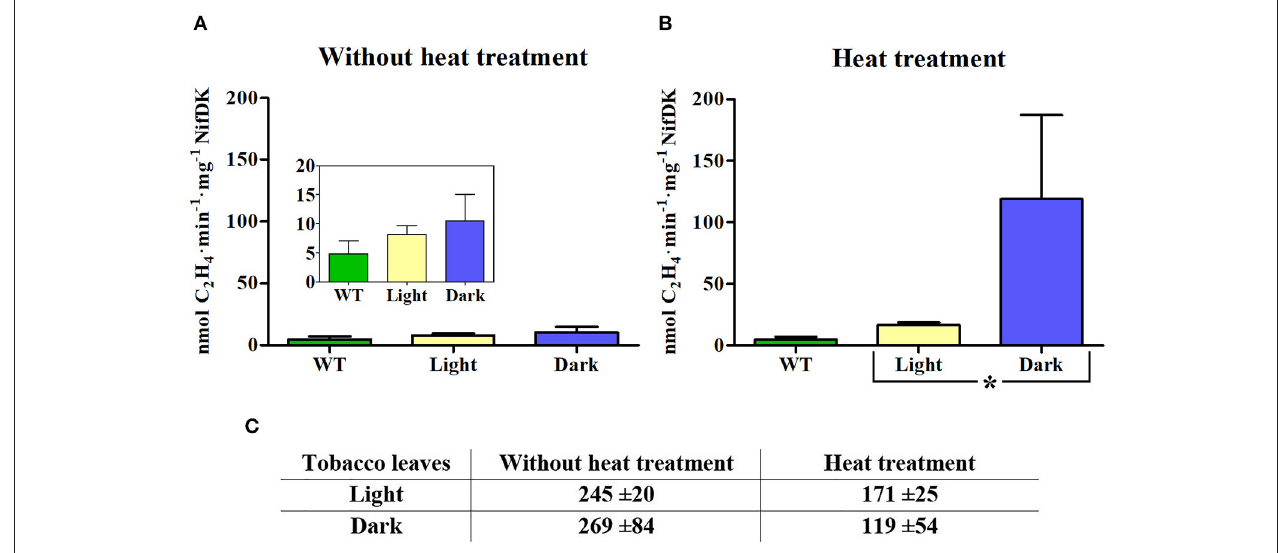
FIGURE 3 | Activity of NifH enriched from light- and dark-incubated leaves. (A, B) ARA at a 9:1 molar ratio of NifH:NifDK using transplastomic NifH isolated from leaves without (A) or with heat treatment (B) of extracts prior chromatography. Protein samples from leaves of wild-type (WT) plants subject to the same enrichment procedure were used as control. Inserts shows activities at zoomed y-axis scale. Average activities ± SD ( n = 3) are shown. Statistically significant differences based on Student’s t-test is shown; * P < 0.05. (C) Total µ g of NifH protein per 100g of leaves present in samples from enrichment experiments. Values represent average content ± SD ( n =